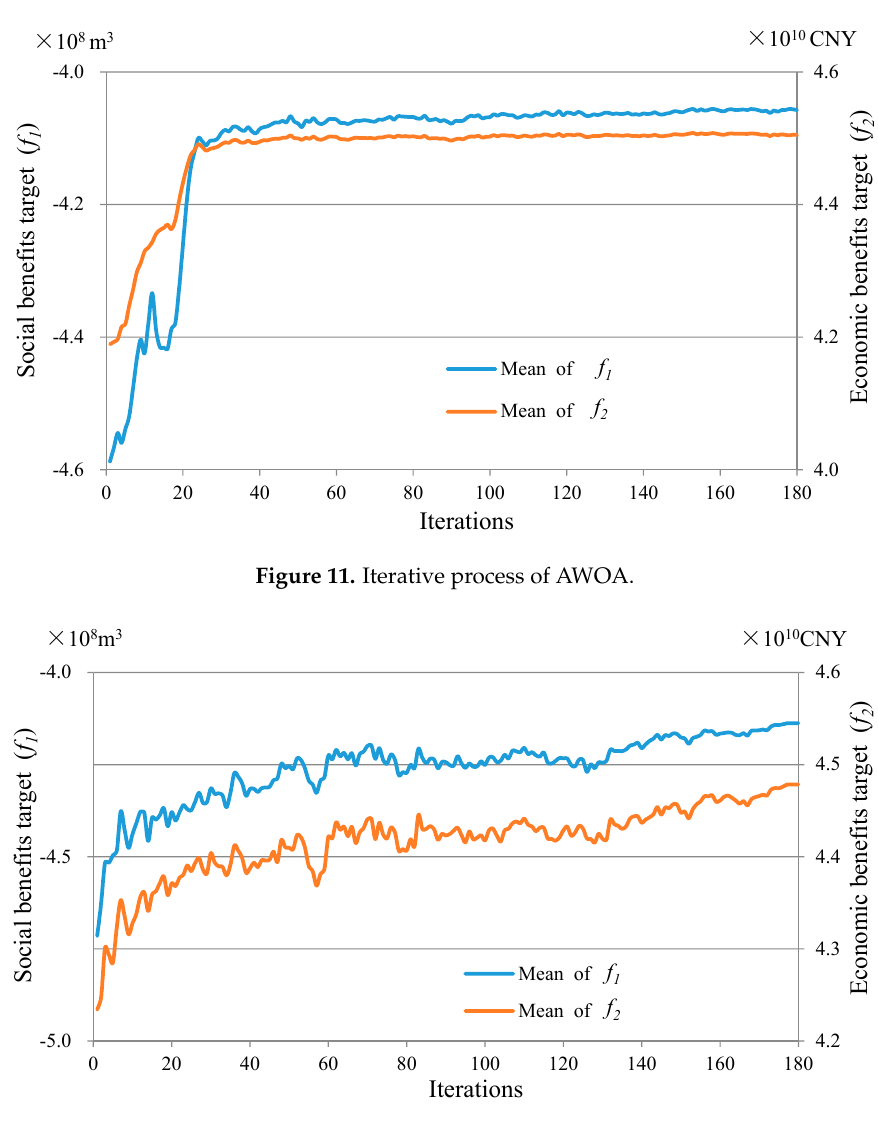
Figure 12. Iterative process of WOA.